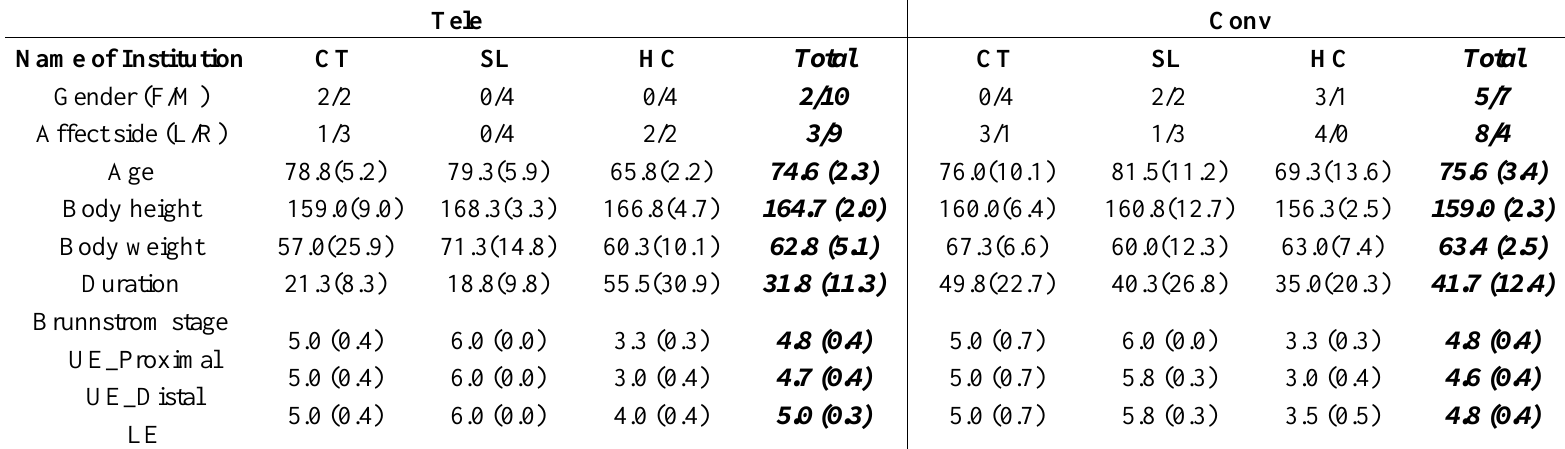
Table 1. Demographic data of participants in the telerehabilitation (Tele) and conventional balance training (Conv) groups. Tele